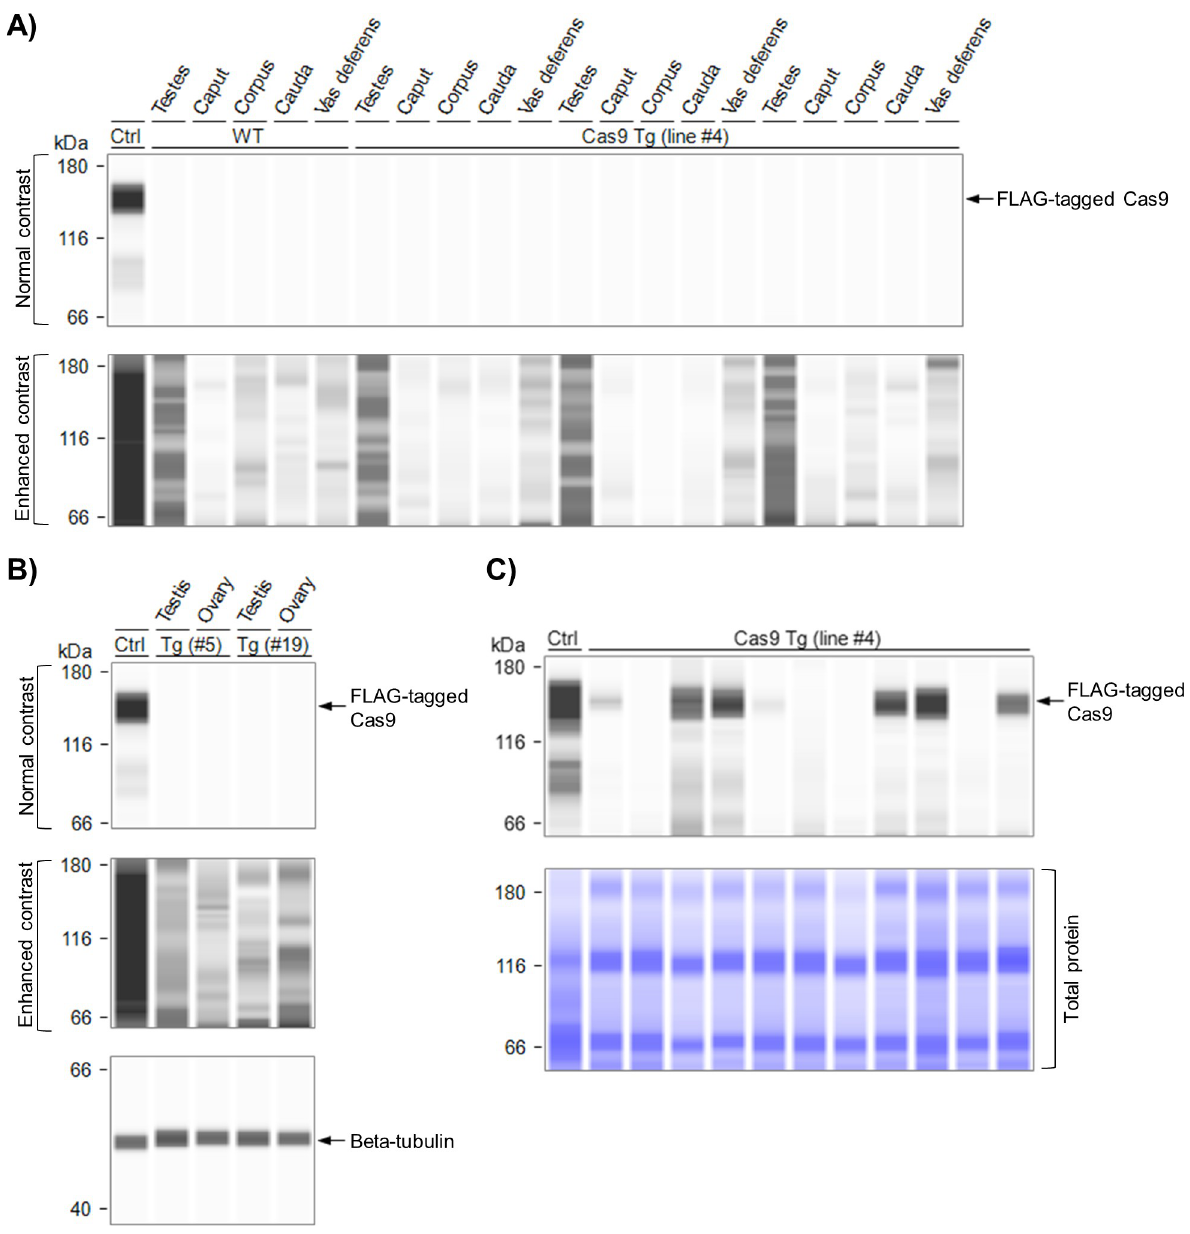
Fig 5. Transgenic mice expressing Cas9 under control of the Prl3b1 promoter do not express Cas9 in the germline. (A–C) Capillary western images showing that Cas9 expression was not detected in male urogenital tract tissues of Prl3b1-eCas9 +/– Tg mice (n = 3) derived from founder 4 (A) or in testes and ovaries of mice derived from founders 5 and 19 (B) but was detectable in 15 dpc embryo-placenta homogenates of line 4 (C) . The positive control (“ctrl”) was a lysate of RK13 cells transiently expressing Cas9. Caput, corpus and cauda are sections of the epididymis. The embryo- placenta tissues (n = 11) were obtained from two litters resulting from crosses between Prl3b1-eCas9 +/– and WT mice (therefore, ~ half of the tissues would be expected to be positive for